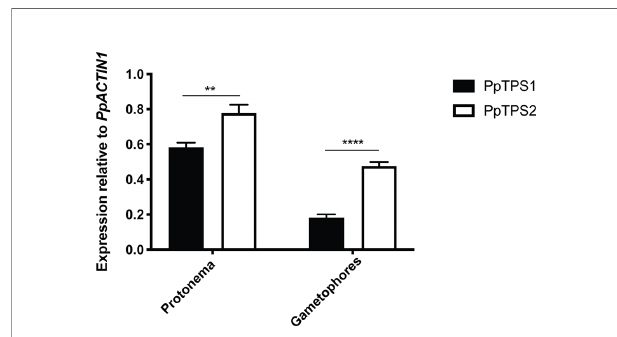
FIGURE 6 | qPCR analysis of PpTPS1 and PpTPS2 in different tissues. Expression of PpTPS1 and PpTPS2 was measured in protonema and gametophores. Data represent the mean ± SD of three biological repeats after normalization with the housekeeping gene PpACT1 . Statistical analysis with multiple t tests, **p ≤ 0.01, ****p